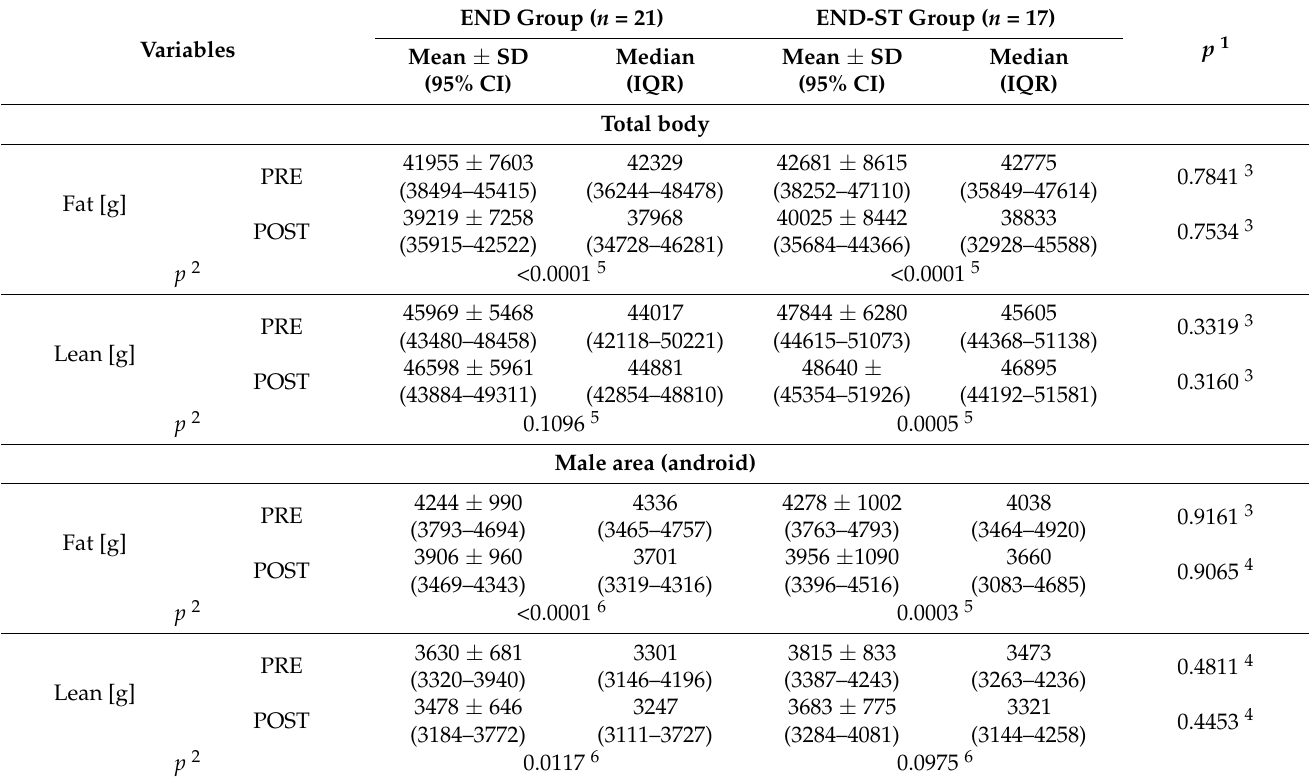
Table 4. The effect of training programmes on body